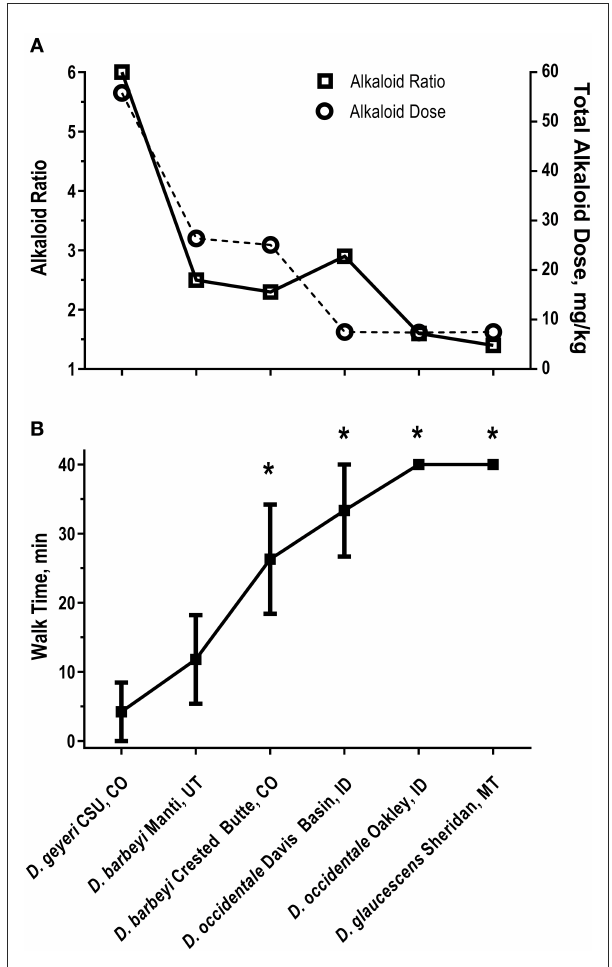
FIGURE2 Alkaloid ratios and dose (A) and walk times (B) in six heifers dosed with larkspur (27). (A) Non-MSAL-type alkaloid to MSAL-type alkaloid ratios on the left y axis and total alkaloid dose on the right y axis. Walk times (min) were related to total alkaloid dose ( r = − 0.91 P = 0.0045) and alkaloid ratio ( r = − 0.80, P = 0.0258). (B) The mean ± SE of Angus heifer walk times 24h after receiving a fixed dose of